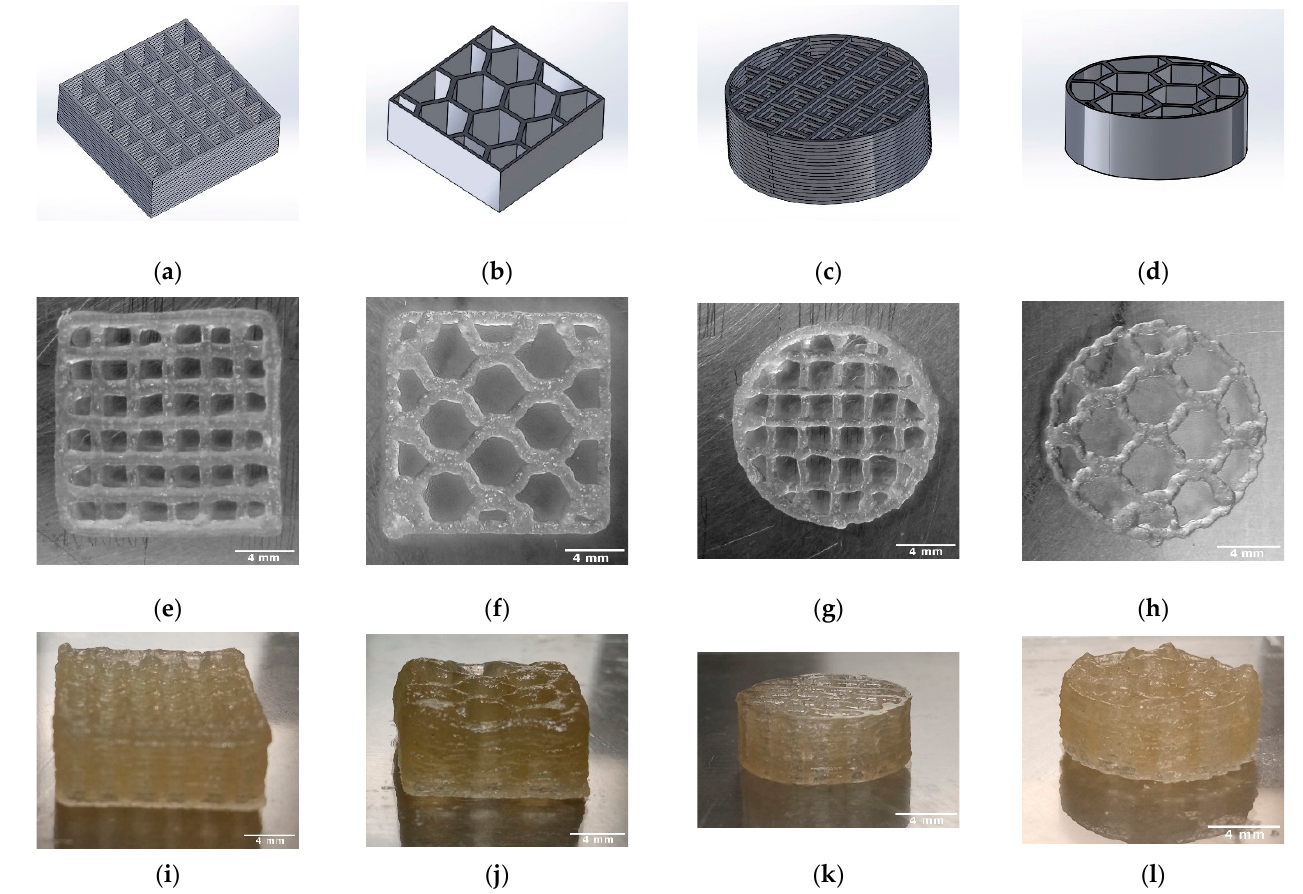
Figure 4. Overview of the 3D printed TC scaffolds with 18 layers; CAD models (SolidWorks ® 2020) ( a – d ); TC scaffold first layer top view ( e – h ); TC scaffold side view ( i – l ). Table 2. Size, weight, and strand width of the 3D printed TC scaffolds (n = 15).